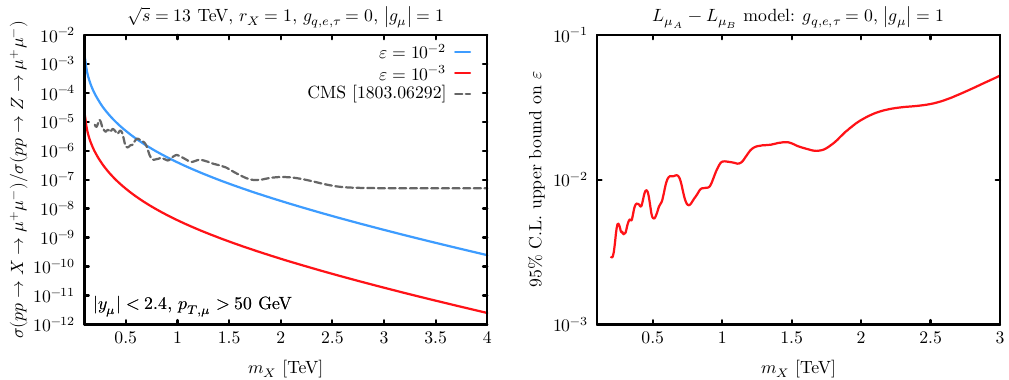
Figure 7 . L (cid:22) (cid:0) L (cid:22) model. Left panel : the ratio of the production cross-section to the SM Z A B cross-section as a function of m X and the 95% C.L. limit from the CMS dilepton resonance search at 13 TeV [106] for the dimuon (cid:12)nal state. Right panel: recast of the CMS limit on the kinetic mixing parameter "